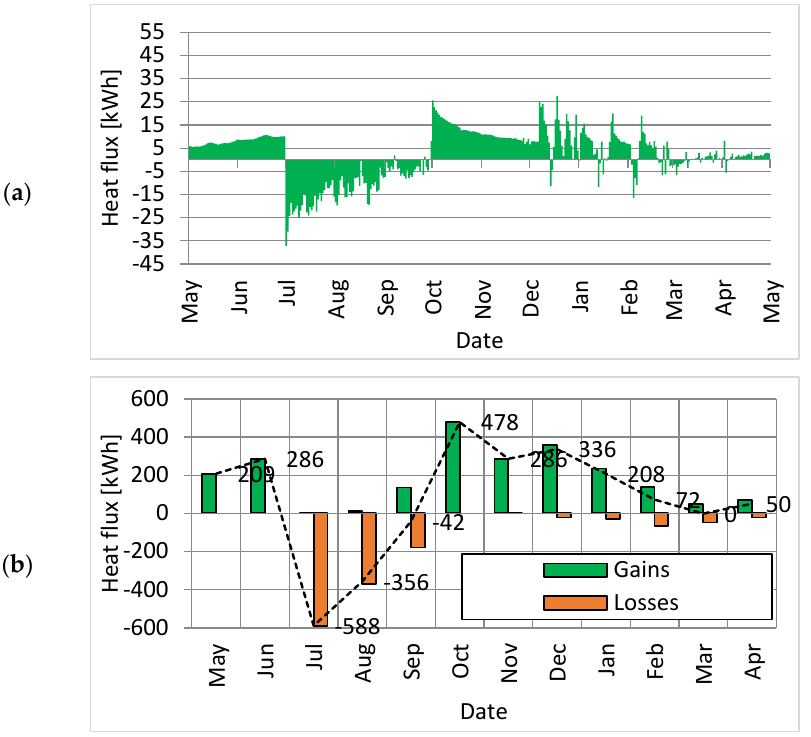
Figure 6. The course of heat exchange between the studied vegetable cold store and the ground: ( a ) hourly course, ( b ) monthly balance.